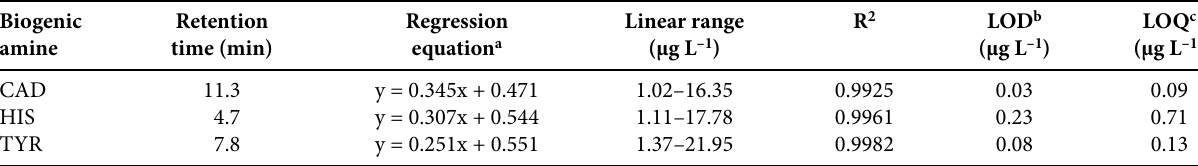
Table 2. Linearity and sensitivity data of the developed RP-HPLC method for the determination of the biogenic amines. Biogenic